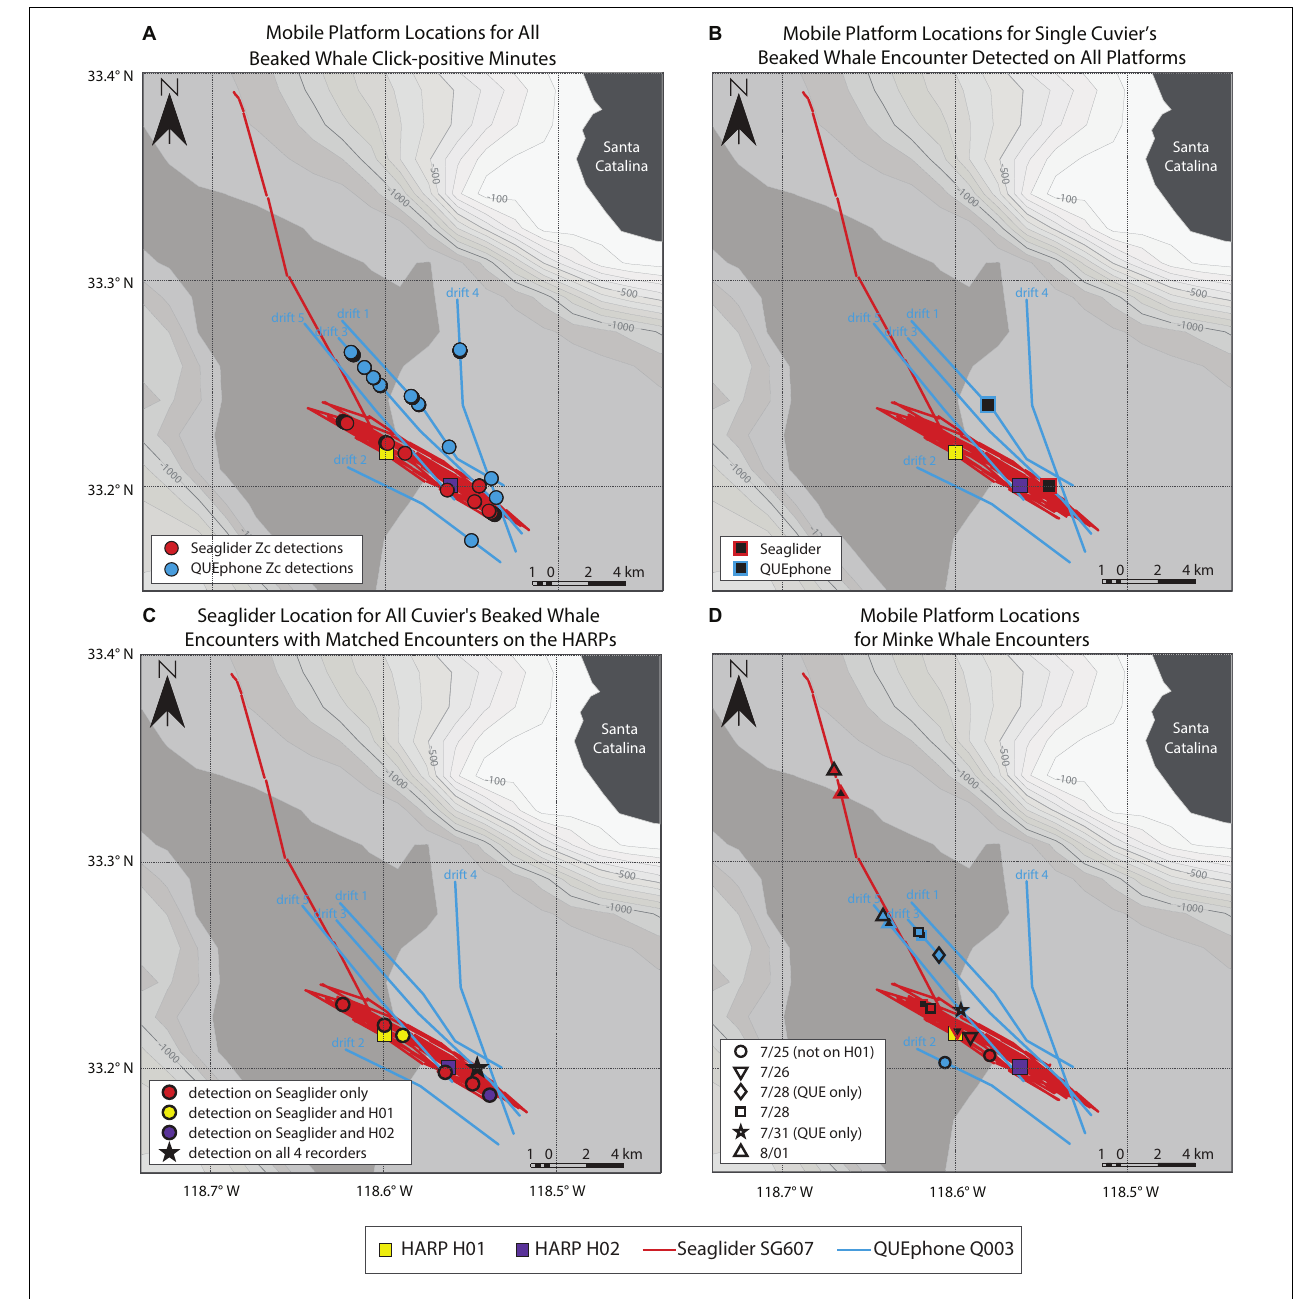
FIGURE 3 | Mobile platform locations where beaked whales (A–C) and minke whales (D) were detected. The Seaglider track is shown as red lines; the track departing to the northwest was for glider recovery at the end of the experiment. The QUEphone drift tracks are shown as blue lines and labeled by drift number. Tracks for both platforms are straight-line interpolations of GPS surface positions. HARP locations are shown as squares (H01 – yellow, H02 – purple). (A) shows the estimated location of each mobile platform for all beaked whale echolocation click-positive minutes. Cuvier’s beaked whale (Zc) click-positive minutes are indicted by circles (Seaglider – red, QUEphone – blue). (B) shows the estimated median location of the Seaglider (red outlined black square) and QUEphone (blue outlined black square) when a single encounter of Cuvier’s beaked whales was recorded by all four deep-water recorders on 07/22/2016 16:32 to 17:17 UTC (09:32 to 10:17 local time). All recorders were within 5.5 km of one another at the time of the encounter. (C) shows the estimated median Seaglider location when it recorded a Cuvier’s beaked whale encounter. Circle color corresponds to which HARP simultaneously recorded the same encounter (encounter detected only on the glider – red, H01 – yellow, H02 – purple). The single encounter recorded by the glider and both HARPs is indicated by a black star (same encounter as in B ). (D) shows the estimated locations of the Seaglider and QUEphone when minke whales boings were detected. Each of six encounters is symbolized by a different shape and encounters were present on all recorders unless otherwise specified in the legend. Platform location at the start (black filled symbol) and end (color fill, black outline symbol) is shown for each encounter. The symbol outline or fill color corresponds to the mobile platform track color (glider – red, QUEphone – blue). If no end symbol (filled black) exists, the encounter was of very short duration with negligible platform movement over the encounter duration, so only a single location is